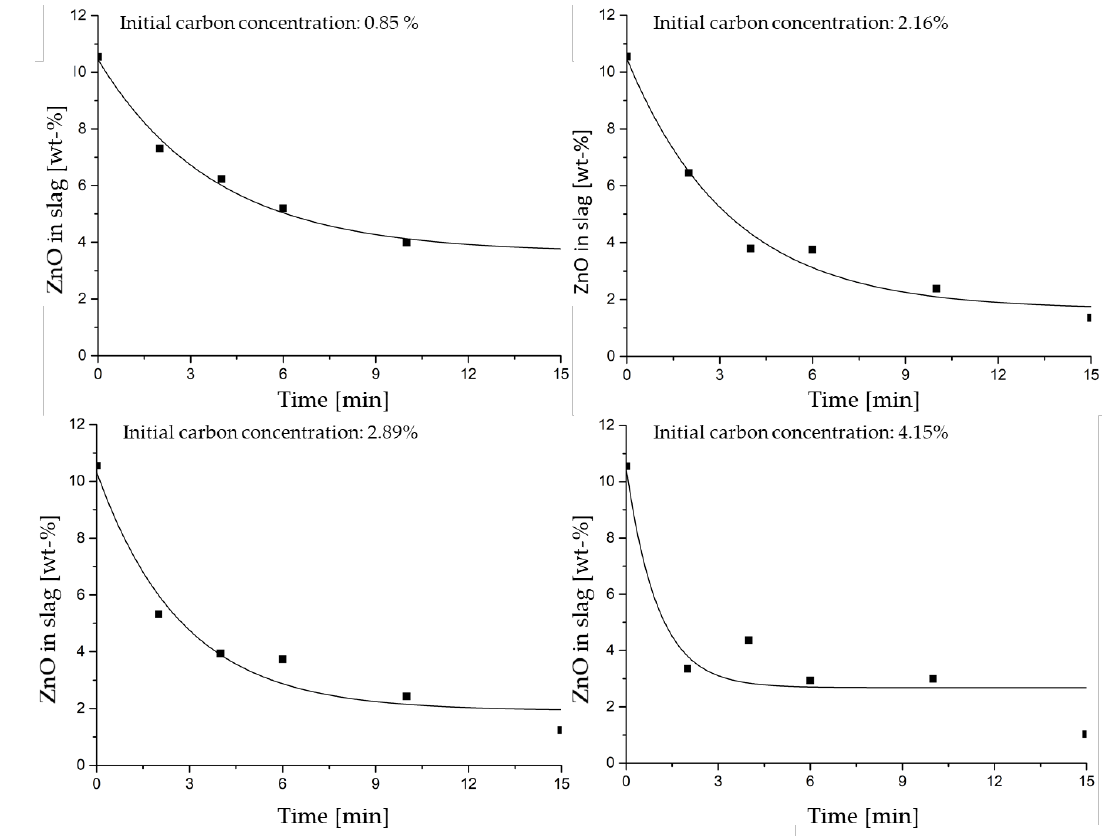
Figure 3. Changes in the zinc oxide content of the slag.